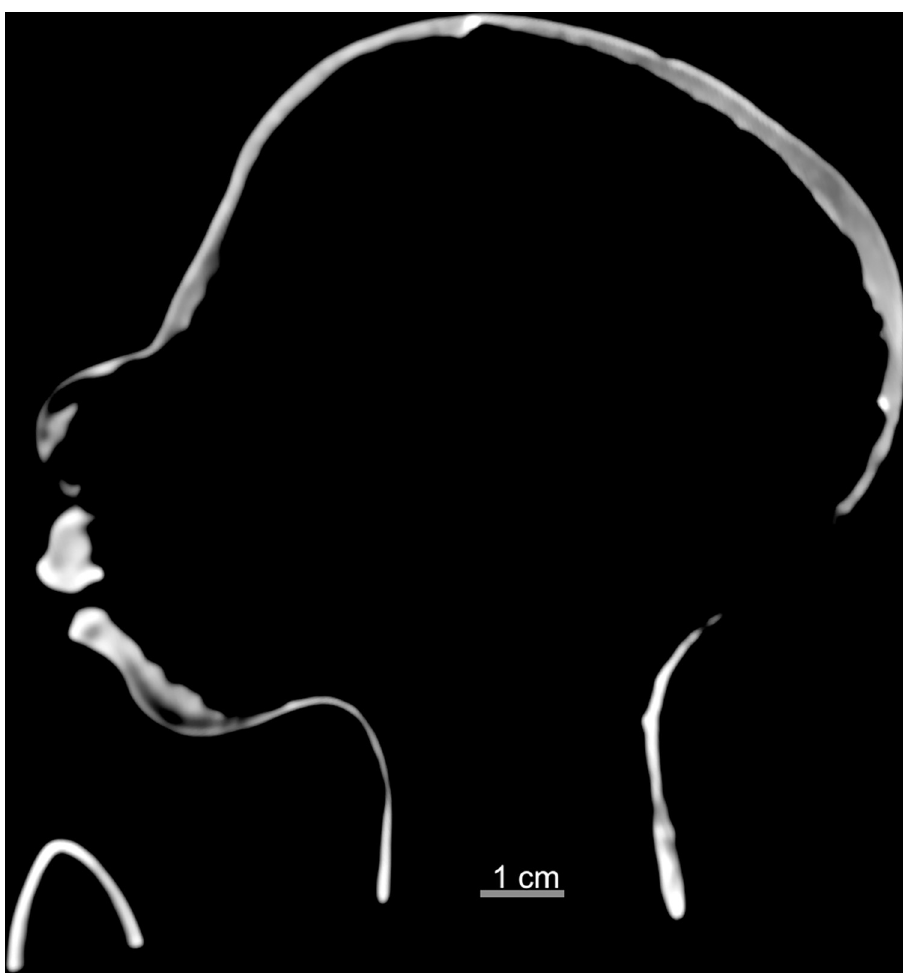
Fig 8. Comparative slice images of the scalp at different resolutions and magnifications. Mid-sagittal slice through the tsantsa –clinical CT scan. The scan has been windowed and leveled to maximize the visibility of the double hiding on the posterior part of the